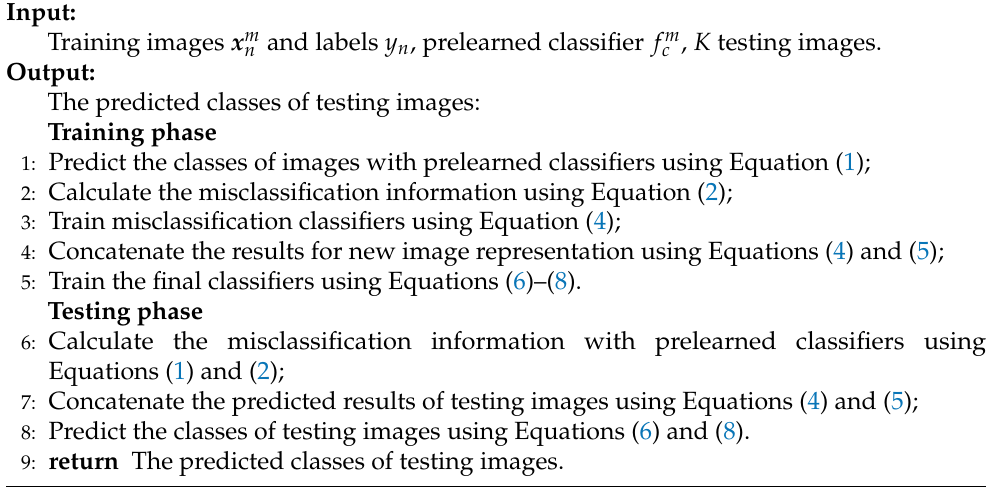
Algorithm 1 Procedures of the proposed fine-grained image classification with misclassifi- cation information method.